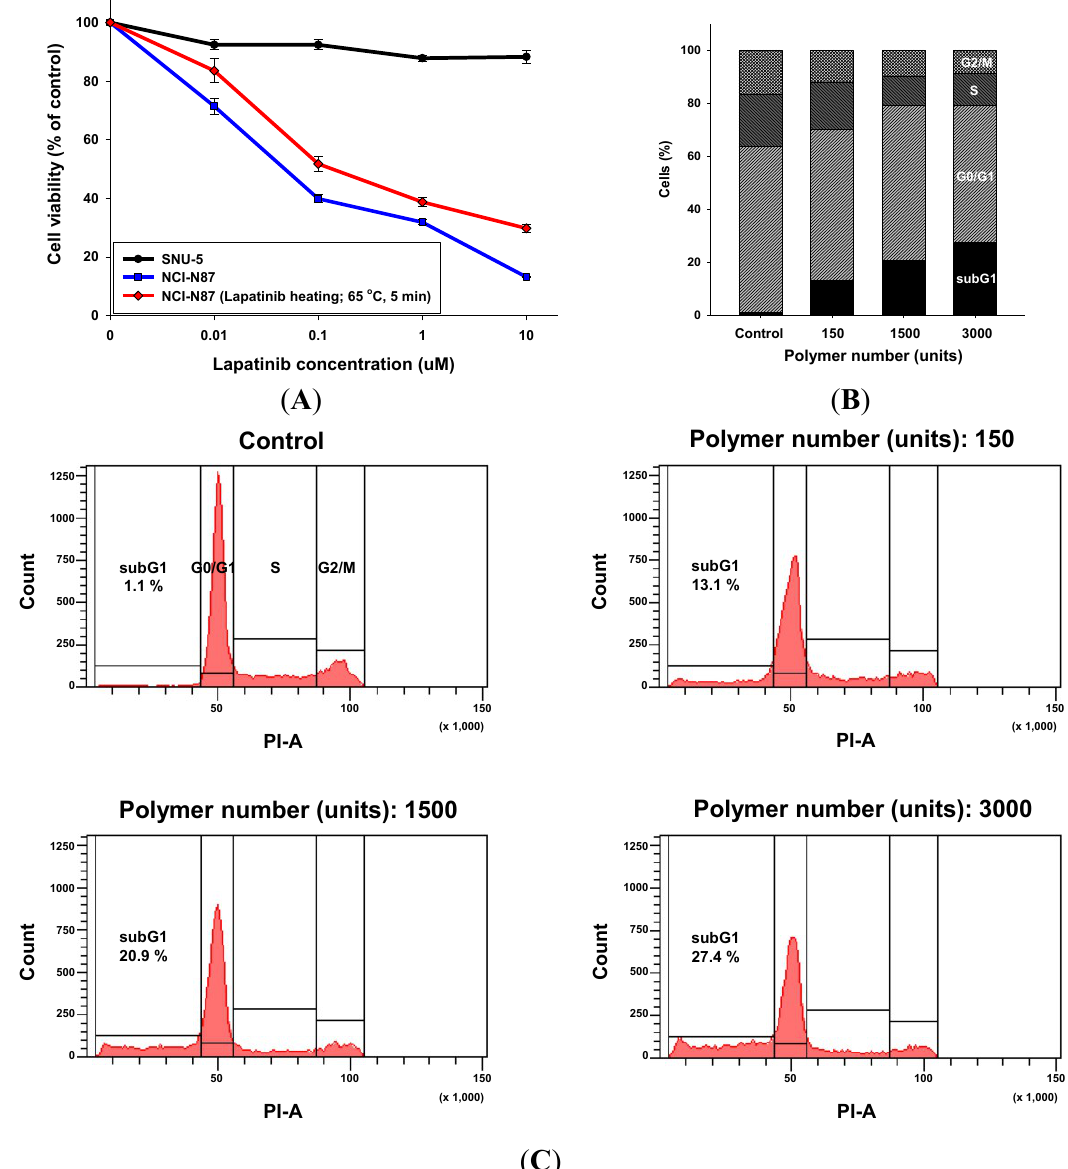
Figure 4. Effects of lapatinib and lapatinib powder-entrapped microstructures on gastric cancer cell lines. ( A ) Cells were plated at 3000 cells/well in a 96-well plate. After 24 h, cells were treated with lapatinib at various concentrations (0.01–10 μM). After 72 h, an MTT assay was performed to evaluate the growth inhibitory activity. The absorbance of each well was measured at 540 nm. The percentage of growth is expressed as a percentage of the control (no drug) cell growth; ( B ) NCI-N87 was treated with lapatinib-entrapped microstructures (150, 1500 and 3000 units per 3 mL of RPMI-1640 medium) for 72 h. After the treatment schedule, cells were analyzed for DNA content by flow cytometry. Proportions of the cells in the subG1, G0/G1, S and G2/M phases were quantified with the FACS Diva program; Control (subG1: 1.1%, G0/G1: 62.6%, S: 19.5%, G2/M: 16.8%), 150 units (subG1: 13.1%, G0/G1: 57.2%, S: 17.5%, G2/M: 12.2%), 1500 units (subG1: 20.9%, G0/G1: 58.3%, S: 10.8%, G2/M: 10.0%) and 3000 units (subG1: 27.4%, G0/G1: 51.8%, S: 12.2%, G2/M: 8.6%); ( C ) Cell cycle phases displayed as a